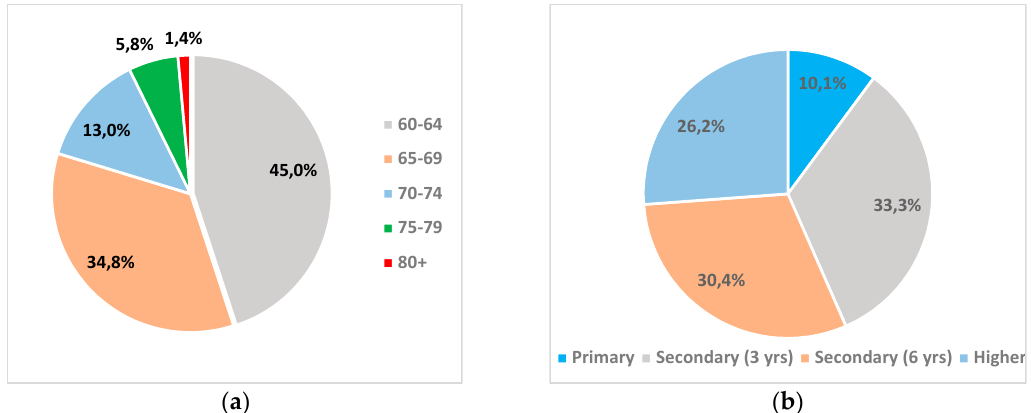
Figure 2. Age distribution ( a ) and education level ( b ) of the 69 participants.